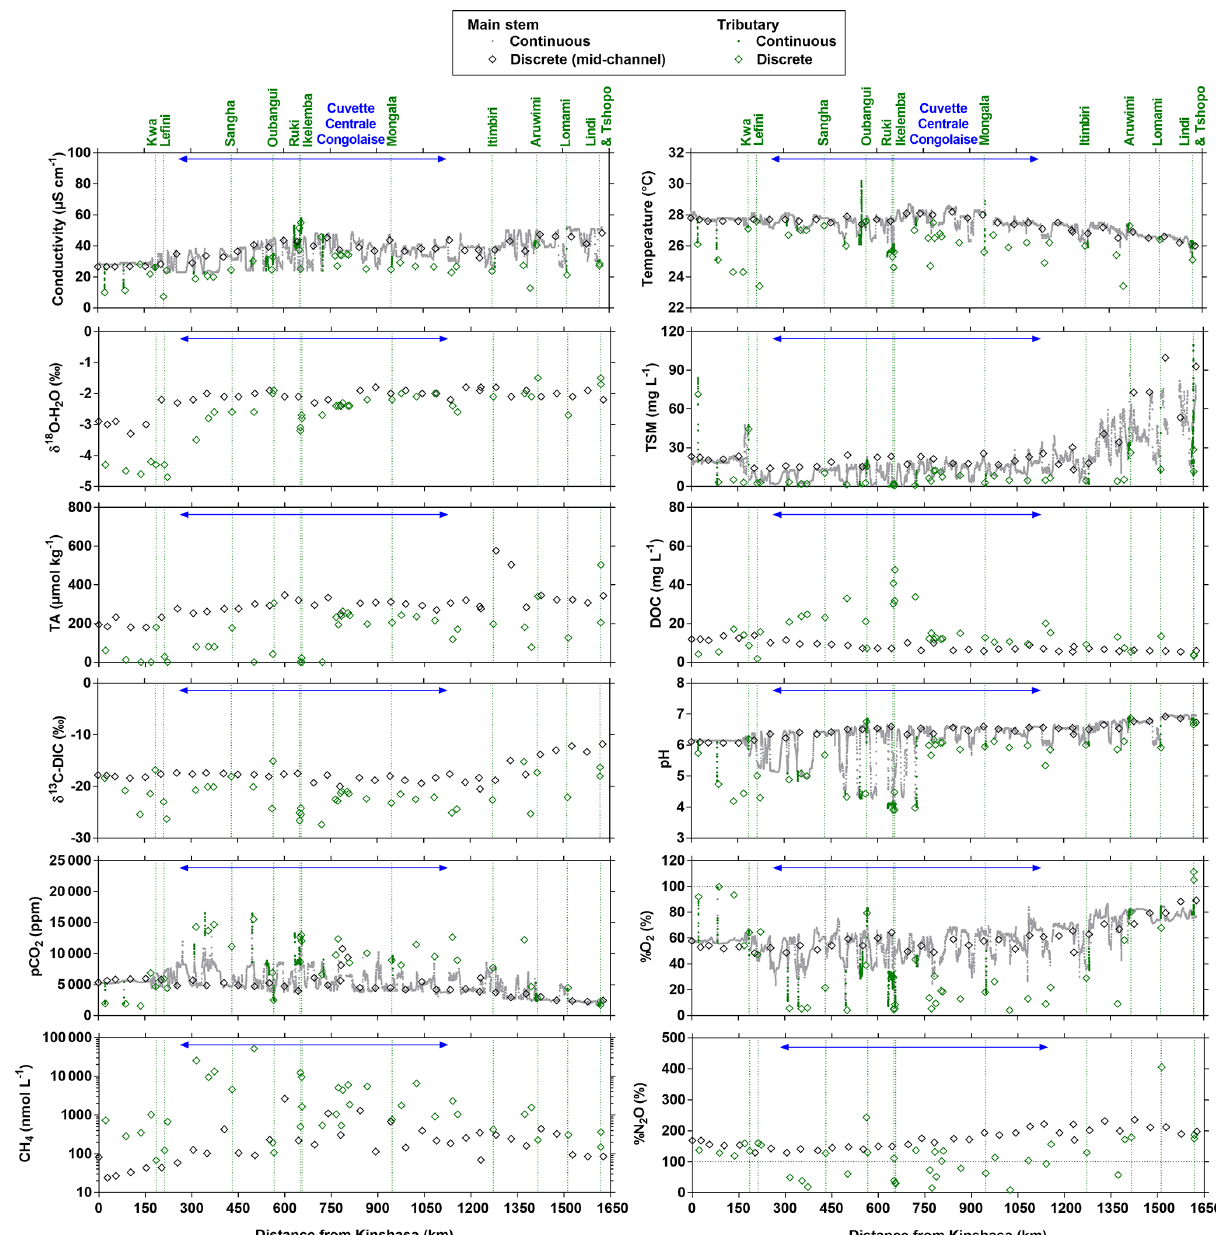
Figure 3. Variation in surface waters of the specific conductivity (µScm − 1 ), water temperature ( ◦ C), oxygen stable isotope composition of H 2 O ( δ 18 O-H 2 O in ‰), total suspended matter (TSM in mgL − 1 ), total alkalinity (TA in µmolkg − 1 ), dissolved organic carbon (DOC in mgL − 1 ), carbon stable isotope composition of dissolved inorganic carbon ( δ 13 C-DIC in ‰), pH, partial pressure of CO 2 ( p CO 2 in ppm), dissolved O 2 saturation level (%O 2 in %), dissolved CH 4 concentration (nmolL − 1 ) and dissolved N 2 O saturation level (%N 2 O in %) as a function of the distance upstream of Kinshasa along a transect along the Congo River from Kisangani (3–19 December 2013, n = 10505). Grey and black symbols indicate samples from the main stem and green samples from